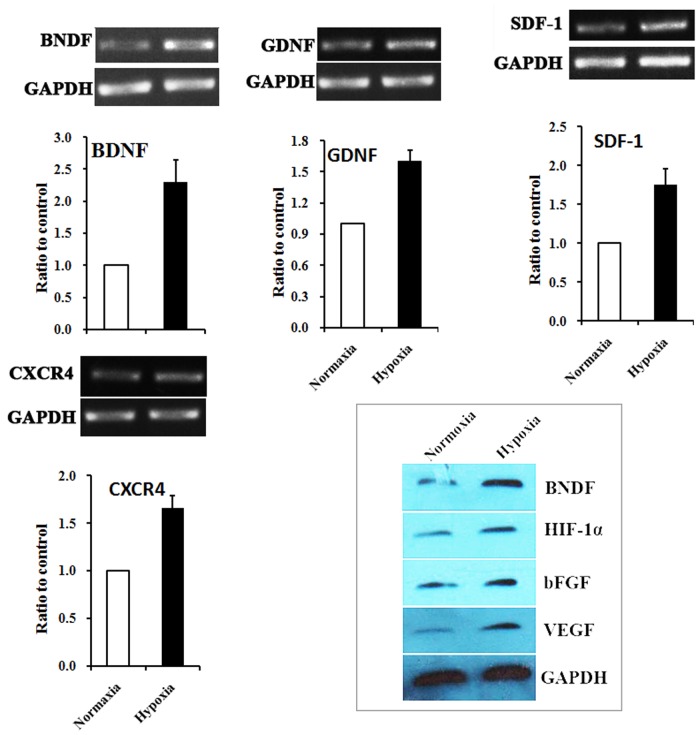
Expression of neurotrophic factors and regenerative factors in AMSCs under normoxia and hypoxia conditions.RT-PCR demonstrated that BNDF and GDNF, important neurotrophic factors, were significantly up-regulated in hypoxia preconditioned AMSCs. Meanwhile, SDF-1 and CXCR4, cytokines closely related with tissue repair, were also significantly up-regulated in AMSCs after hypoxia precondition (P<0.01 in each factor).